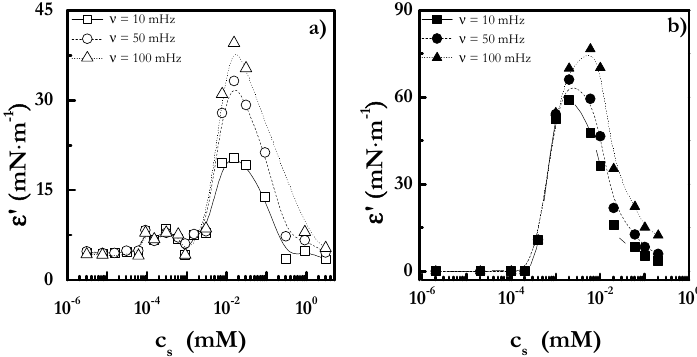
Figure 5. ( a ) Concentration dependences of the elastic modulus for PDADMAC-SLMT adsorption layers as were obtained from oscillatory barrier experiments performed at different frequencies. ( b ) Concentration dependences of the elastic modulus for PDADMAC-SLES adsorption layers, obtained from oscillatory barrier experiments performed at different frequencies. Note: ( □ and ■ ) ν = 0.01 Hz; ( ○ and ● ) ν = 0.05 Hz; ( Δ and ▲ ) ν = 0.10 Hz. The lines are guides for the eyes. For the sake of clarity, only results corresponding to some of the explored frequencies ( ν ) are shown, with the other frequencies presenting similar dependences. The results correspond to PDADMAC-surfactant mixtures containing a fixed PDADMAC concentration of 0.5 wt.%, and left to age for one week prior to measurement.